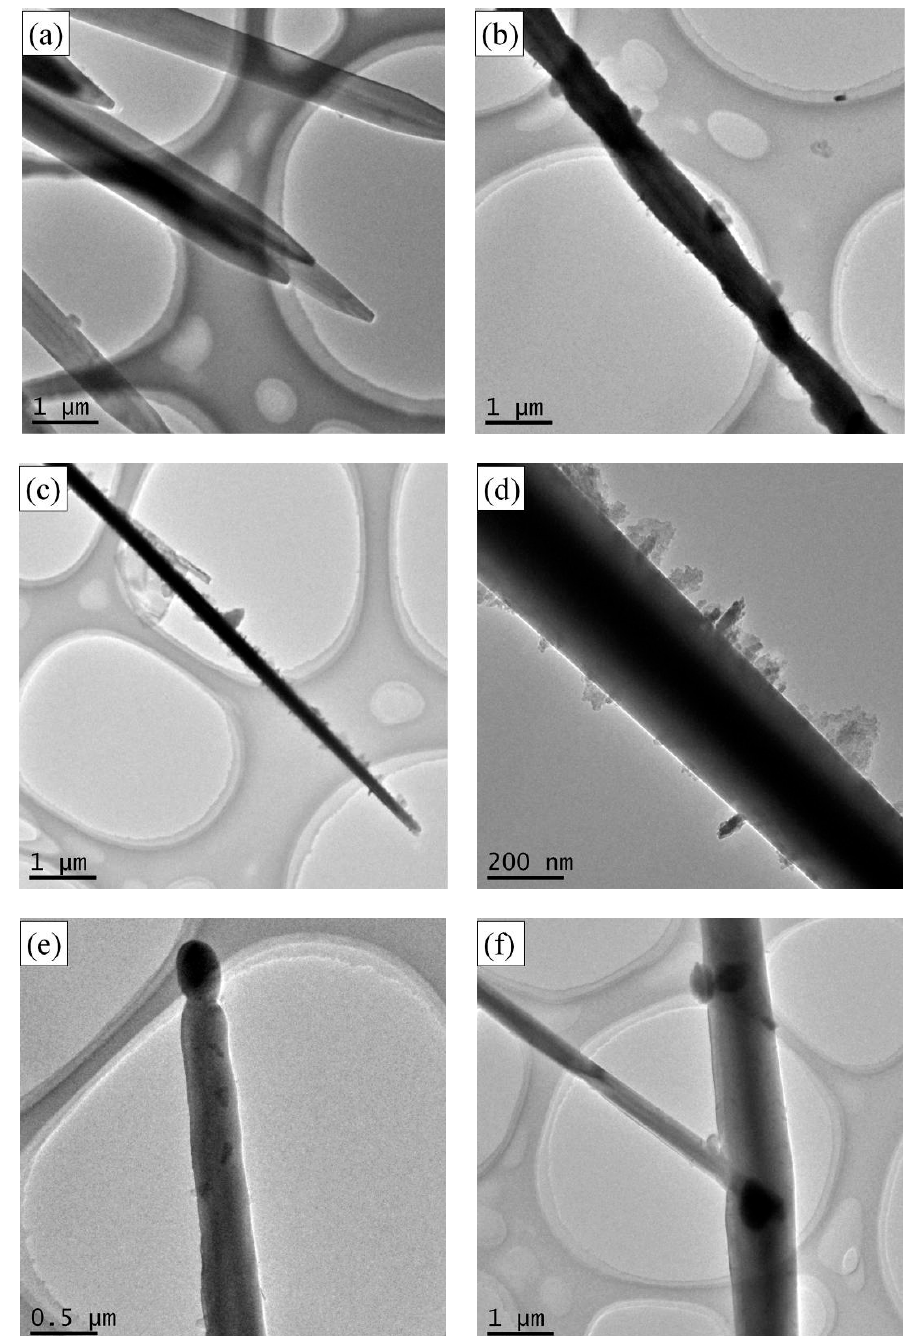
Figure 3. TEM images of fiber ‐ like nitride products. ( a ) overlapped, ( b ) twist and ( c , d ) rough features, ( e , f ) droplets of fibers.